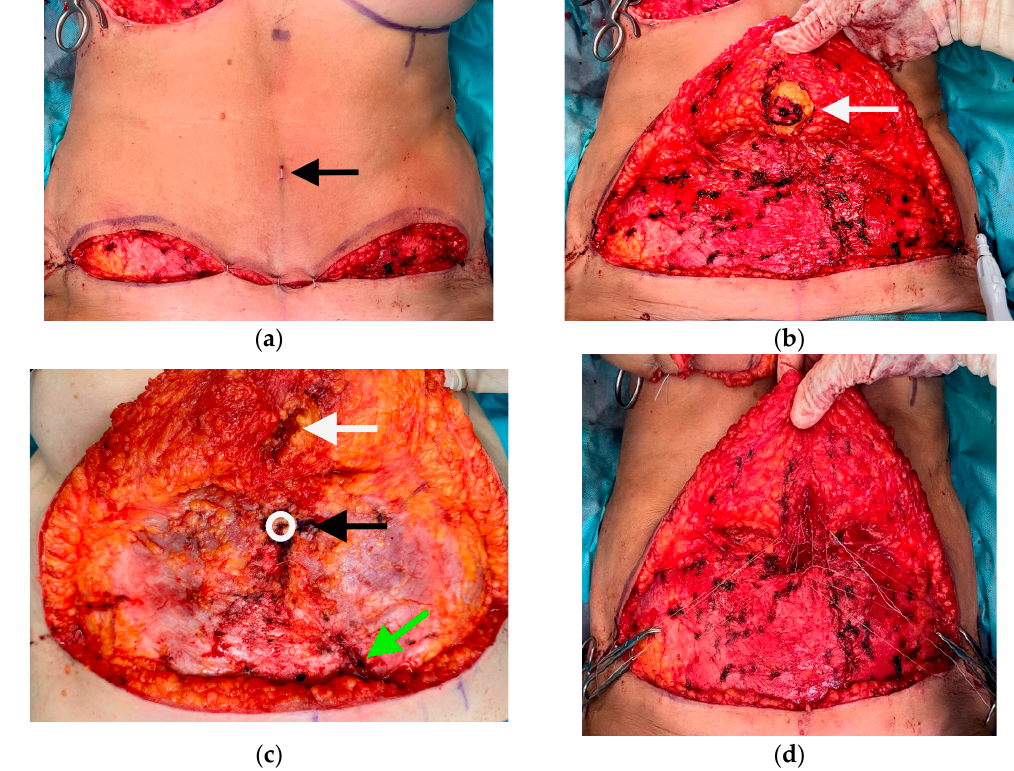
Figure 2. ( a ) Intraoperative marking of the new position of the umbilicus on the abdominal wall with a stapler (arrow) after temporary closure. ( b ) Cylindric resection (arrow) of the abdominal wall tissue up to the dermis. ( c ) Intraoperative situs; black arrow: position of the new umbilicus on the rectus sheath after resecting the umbilicus, sutures will be placed clockwise in the 3,6,9, and 12 positions. White arrow: corresponding resected fat cylinder from the abdominal wall. Green arrow: closure of rectus sheath after DIEP-pedicle harvest. ( d ) Clockwise prepared 3-0 Vicryl sutures in the 3,6,9, and 12 positions.